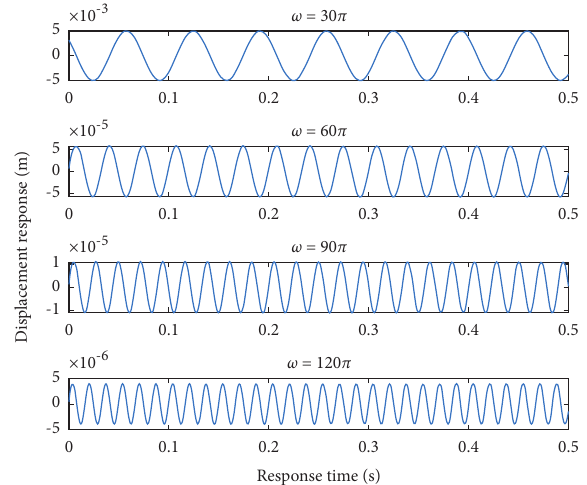
Figure 15: Time-domain response of the main beam under dif- ferent excitation frequencies.